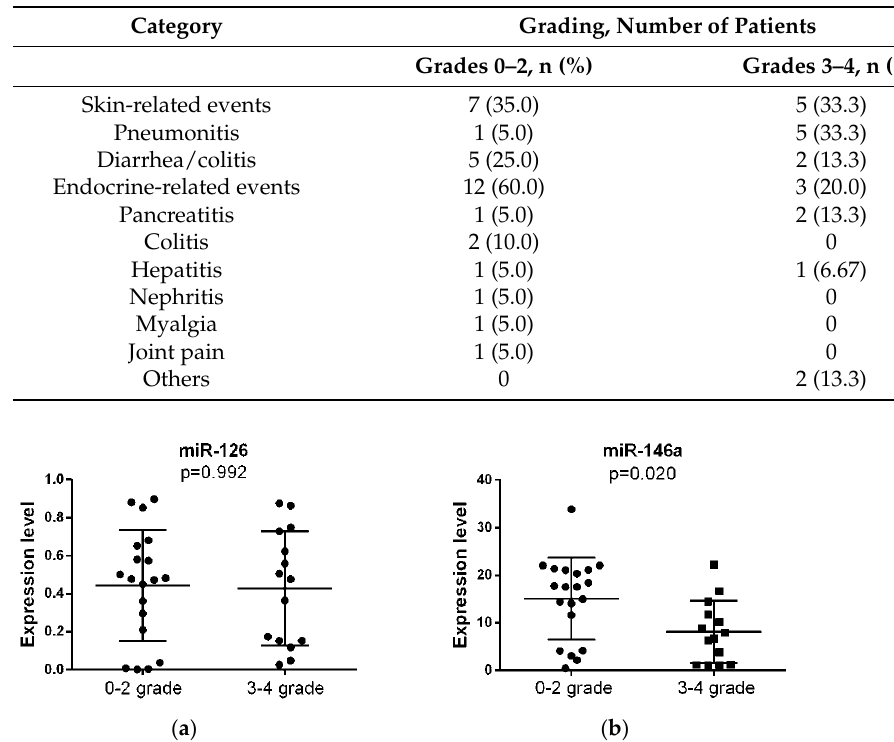
Table 2. IrAEs in RCC patients according to category and grade.